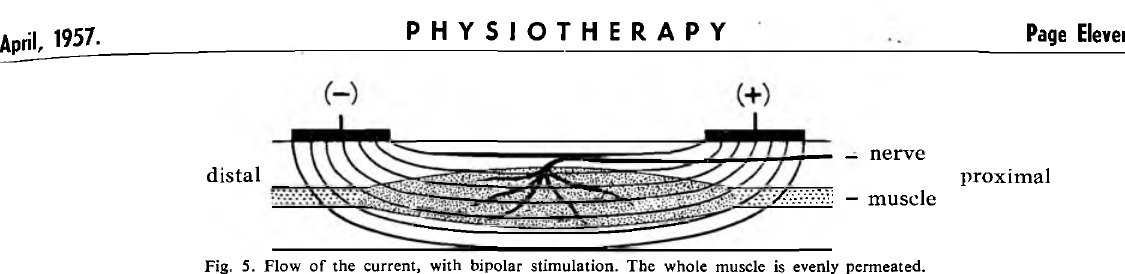
Fig. 5. Flow of the current, with bipolar stimulation. The whole muscle is evenly permeated.